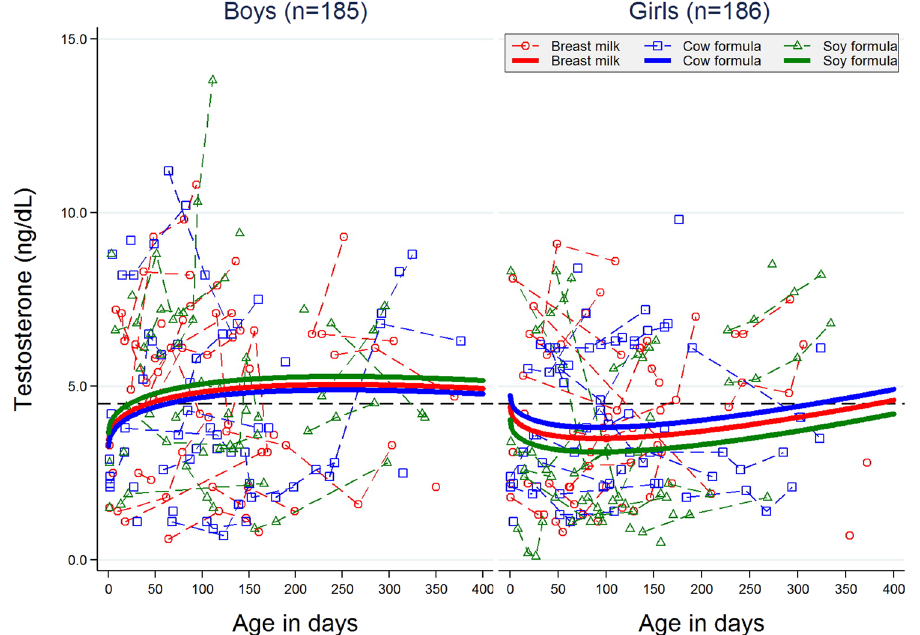
Figure 1. Urinary testosterone concentration (ng/dL) as a function of age (d). Plotted points are individual sample values, and those connected by line segments represent multiple visits by the same infant. Plotted nonlinear trajectories were fitted using generalized mixed model for individual sample values (2 values < 0.5 were